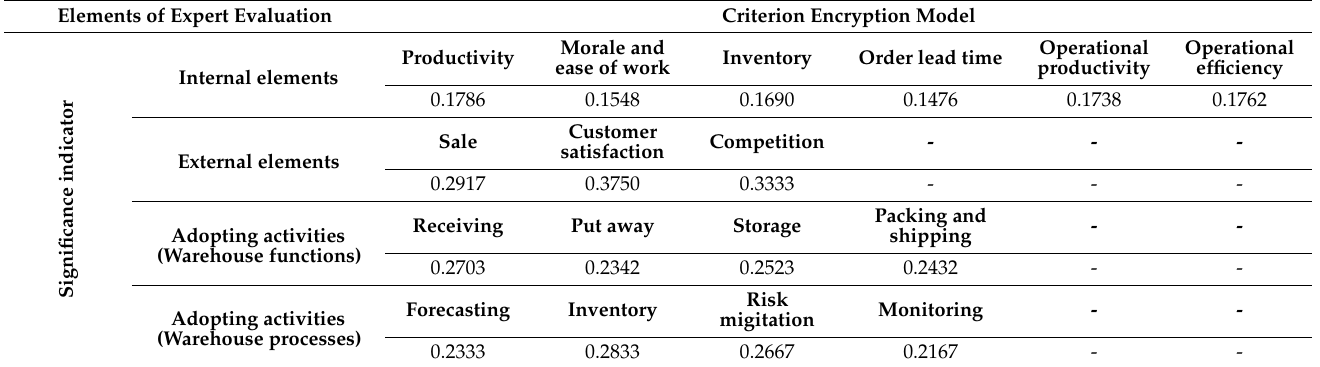
Table 14. The results of the indicator